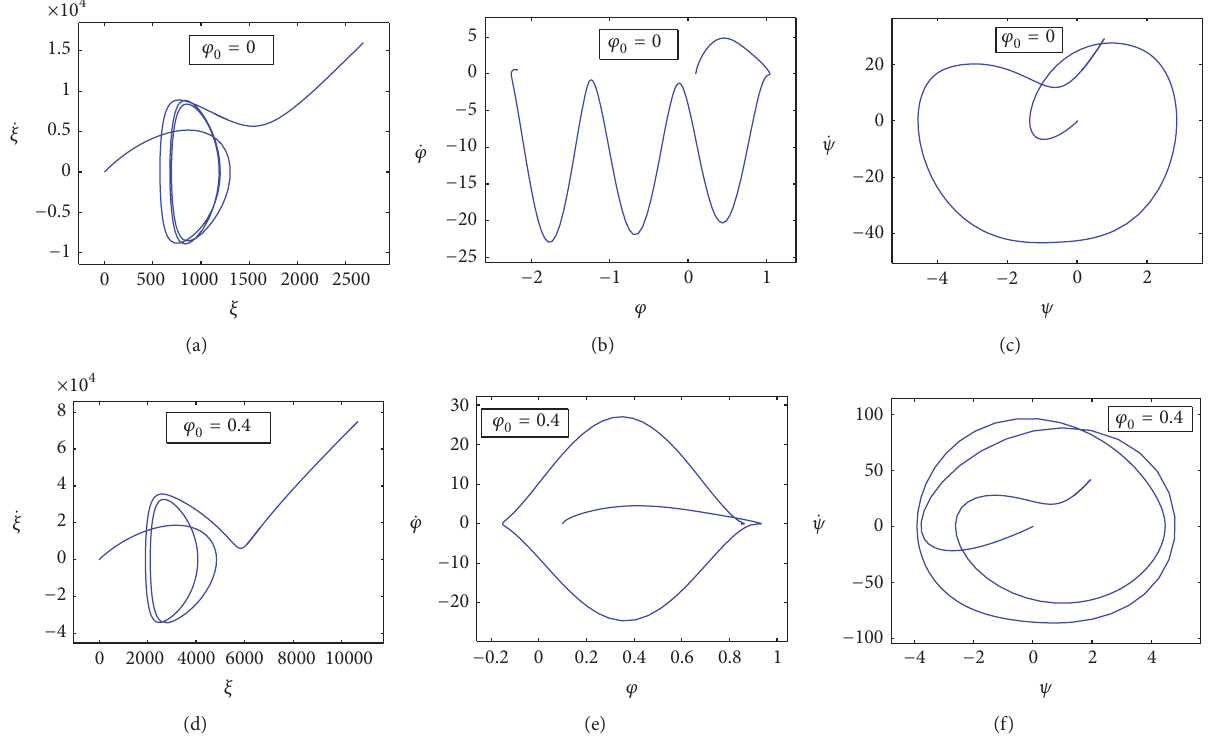
Figure 3: The phase plane diagram when 𝑏 = 3 m, ℎ = 4.5 , and 𝑎 = 0.5 m: (a, d) represent the variation of the amplitude 𝜉 with its velocity ̇𝜉 at 𝜑 0 = 0 and 𝜑 0 = 0.4 rad, respectively, (b, e) represent the variation of the amplitude 𝜑 with its velocity ̇𝜑 at 𝜑 0 = 0 and 𝜑 0 = 0.4 rad, respectively, and (c, f) represent the variation of the amplitude 𝜓 with its velocity ̇𝜓 at 𝜑 0 = 0 and 𝜑 0 = 0.4 rad,